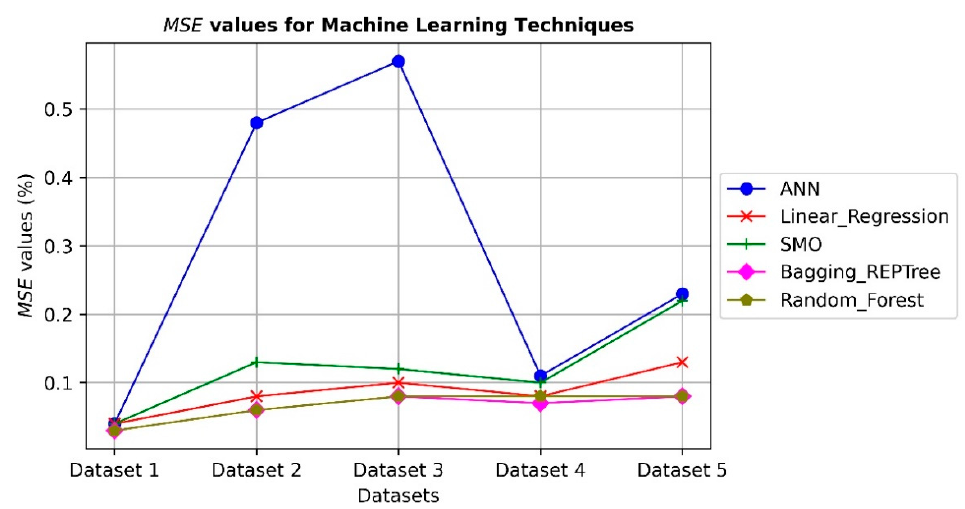
Figure 3. The results of using ML techniques on depression dataset MSE.